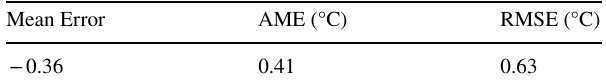
Fig. 5 The observed and simu- lated elevation versus volume of the Yamchi dam reservoir